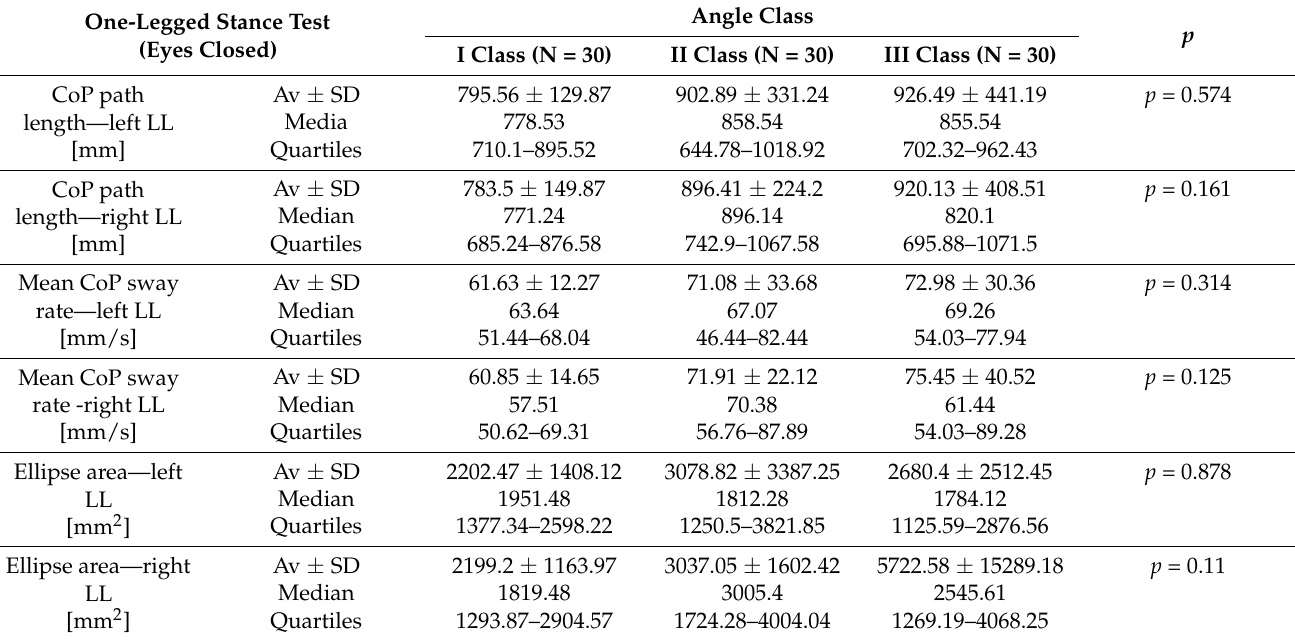
Table 6. Results of selected stabilographic examination parameters (one-legged stance test, eyes closed) in groups with I, II and III Angle